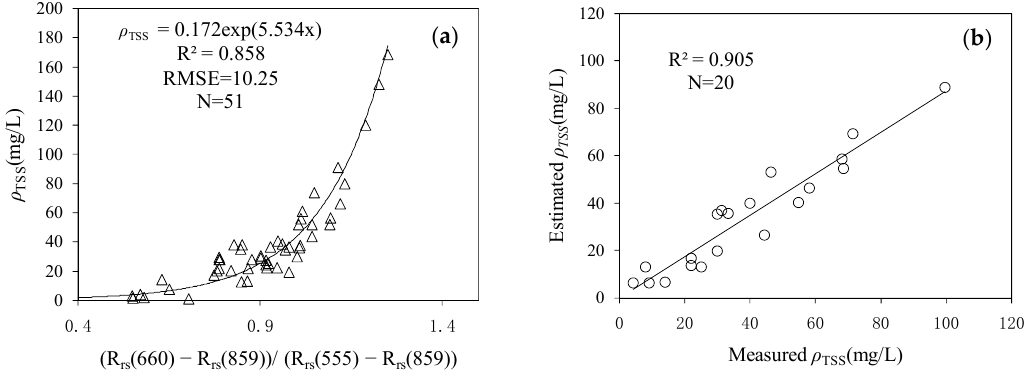
Figure 5. The fitting model between in situ TSS and a simulated MODIS-derived band combination and its validation. ( a ) the fitting model; ( b ) validation of the model.